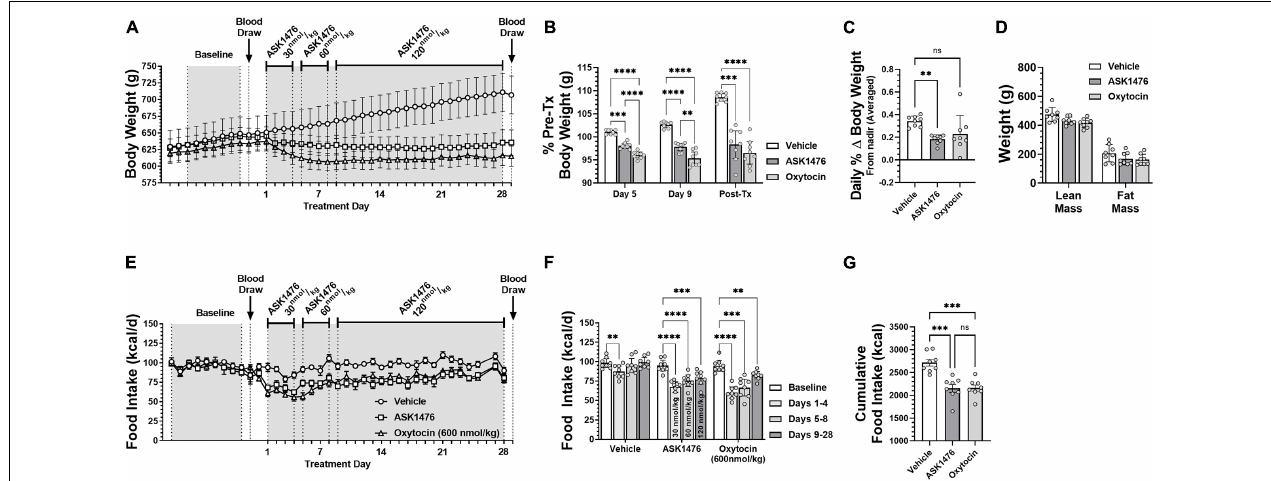
FIGURE 6 | The effects of long-term (28-day) treatment with ASK1476 (starting dose 30 nmol/kg day, then increase to 60 and finally 120 nmol/kg/d) or oxytocin (OXT; 600 nmol/kg/d) on weight gain and food intake in DIO rats. Long-term reductions of body weight were observed in both ASK1476 and OXT treatment groups without compensatory weight regain (A) . OXT 600 nmol/kg/d yielded significantly greater reductions in body weight than ASK1476 at both the 30 nmol/kg and 60 nmol/kg doses, however, the effect of ASK1476 dosed at 120 nmol/kg/d was more comparable (B) . Both ASK1476 and OXT treated animals resisted compensatory weight gain throughout the 28-d treatment period with significantly lower rates of weight regain following body weight nadir (C) . Post-treatment body composition analyses indicated no difference in either percent lean or fat mass relative to vehicle for either OXT or ASK1476 (D) . ASK1476 120 nmol/kg/d was similarly effective as oxytocin 600 nmol/kg/d at attenuating caloric intake across the 28-day experiment (E) . Food intake remained significantly reduced across the 28-day treatment for both OXT and ASK1476 (F) with the two treatments yielding comparable effects on cumulative food intake (G) . Post hoc analyses with p -values adjusted for multiple comparisons: ∗∗ p < 0.01; ∗∗∗ p < 0.001; ∗∗∗∗ p <